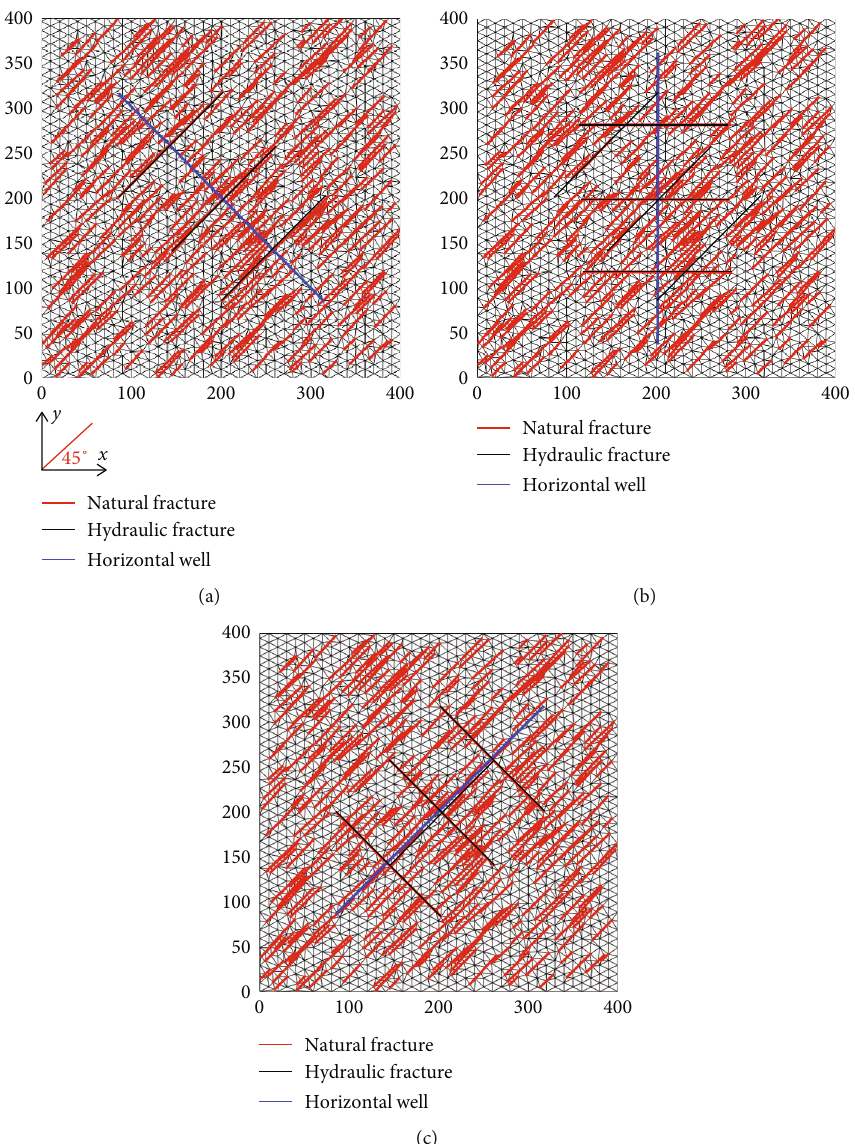
Figure 10: Densely fractured models with di ff erent strategies of well placement: (a) θ = 90 ° ; (b) θ = 45 ° ; (c) θ = 0 °